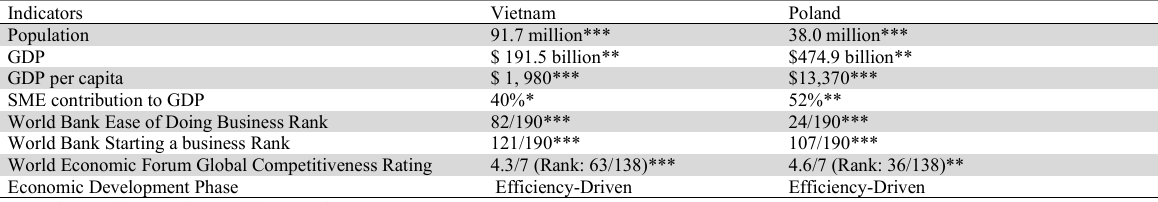
Economic indicators for Vietnam and Poland